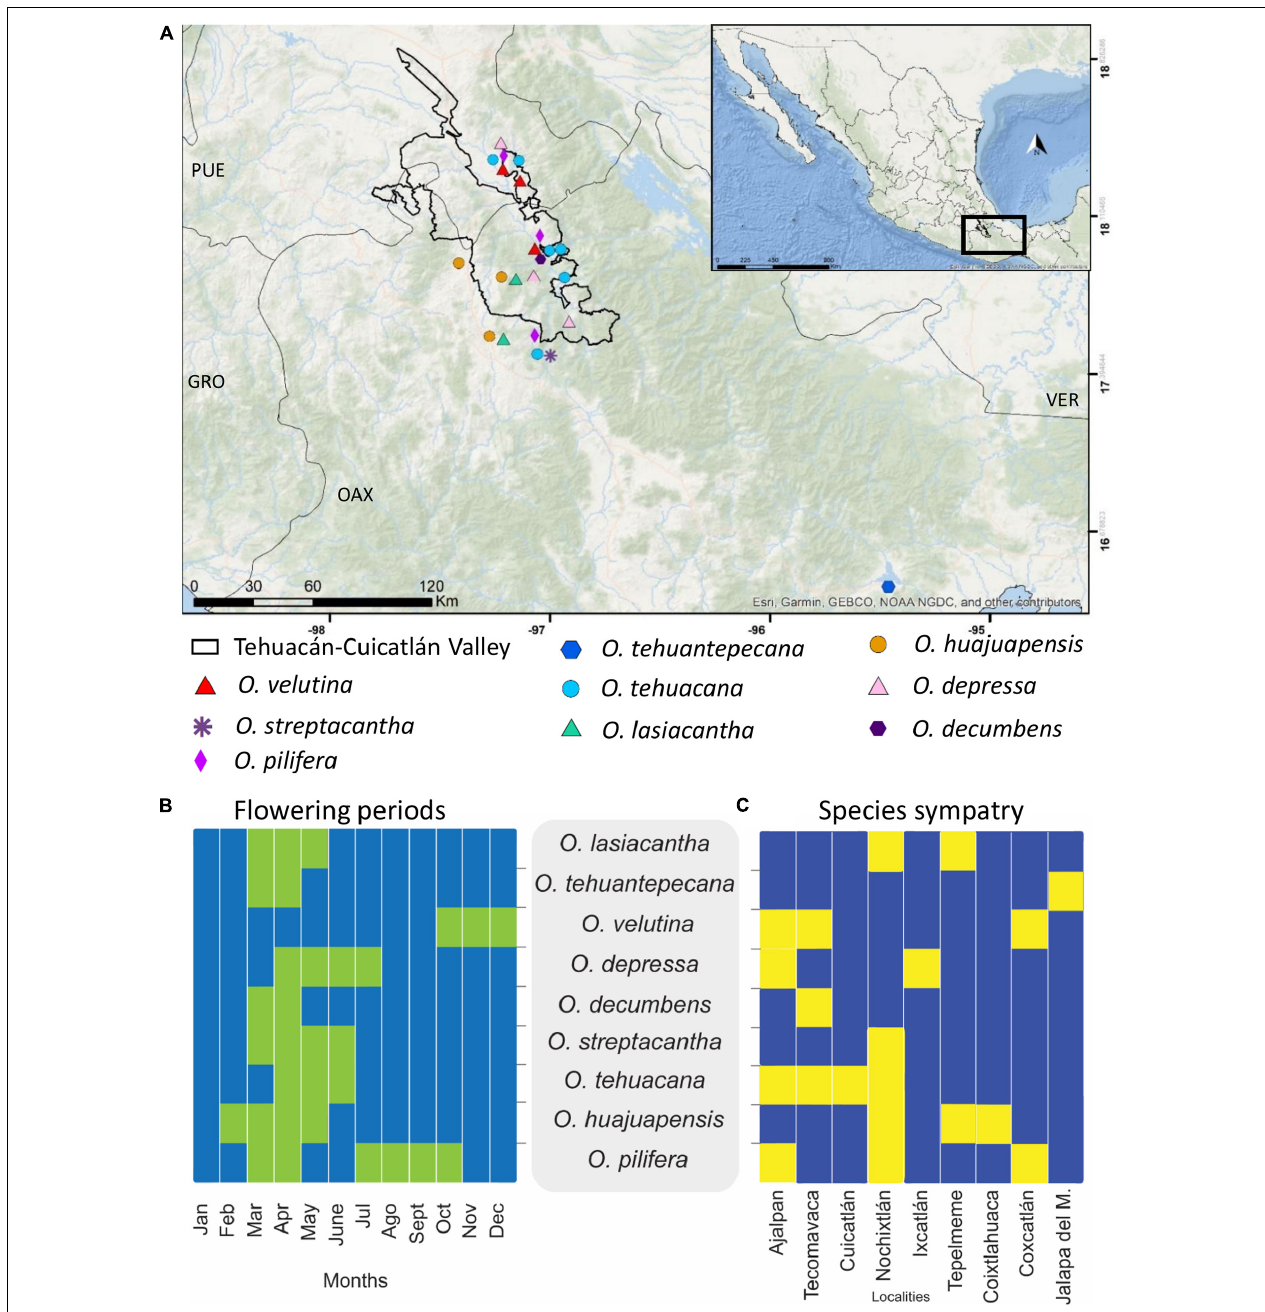
FIGURE 2 | The Opuntia species from Tehuacán-Cuicatlán Valley and other species collected in Mexico evaluated on this work. (A) Sampled localities in field trips. (B) Heatmap showing in green overlap of flowering months between sampled species, data from Arias et al. (2012). (C) Heatmap showing in yellow species sympatry per sampled